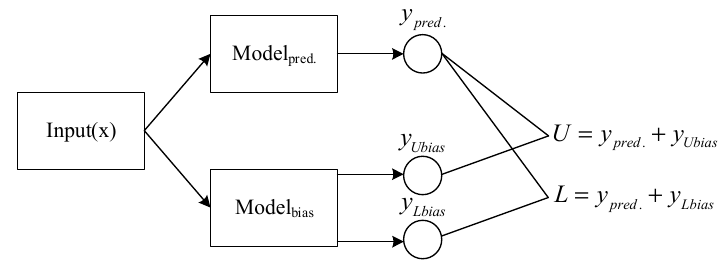
Figure 1. Schematic of the proposed framework for construction of PIs.